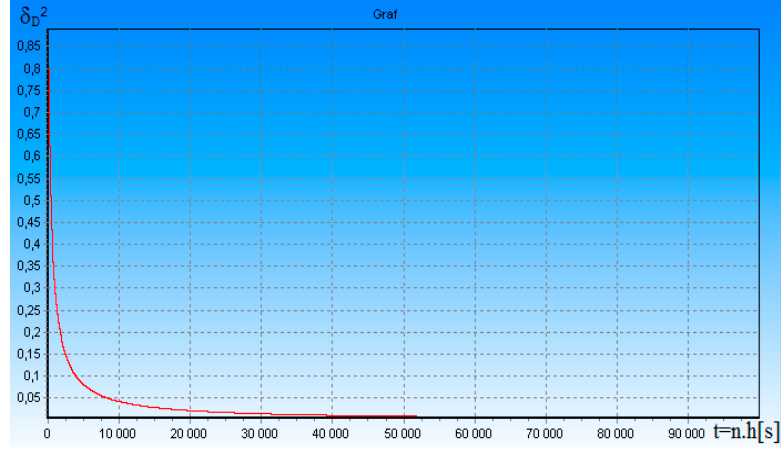
Figure 1. Dependence of the δ D2 of standardized measurement error of the slant range D(t) between FO (Flying Object) and distance-measuring equipment (DME), on time t.